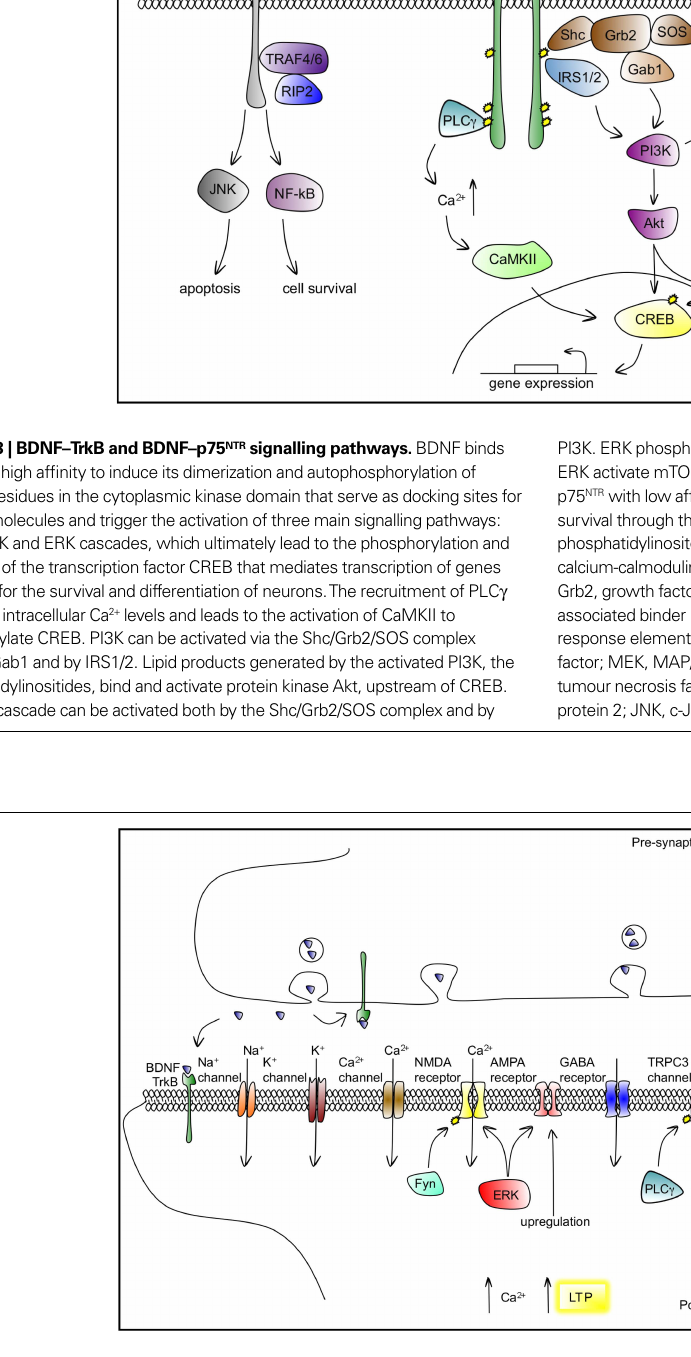
open, via PLC γ , a process also acting in the range of minutes. BDNF enhances glutamatergic neurotransmission by increasing open probability of NMDA (by promoting its phosphorylation, via Fyn-dependent and Fyn-independent mechanisms) and by upregulating AMPA expression. ERK signalling is involved in both NMDA and AMPA gating. In the millisecond range, BDNF/TrkB can directly gate the